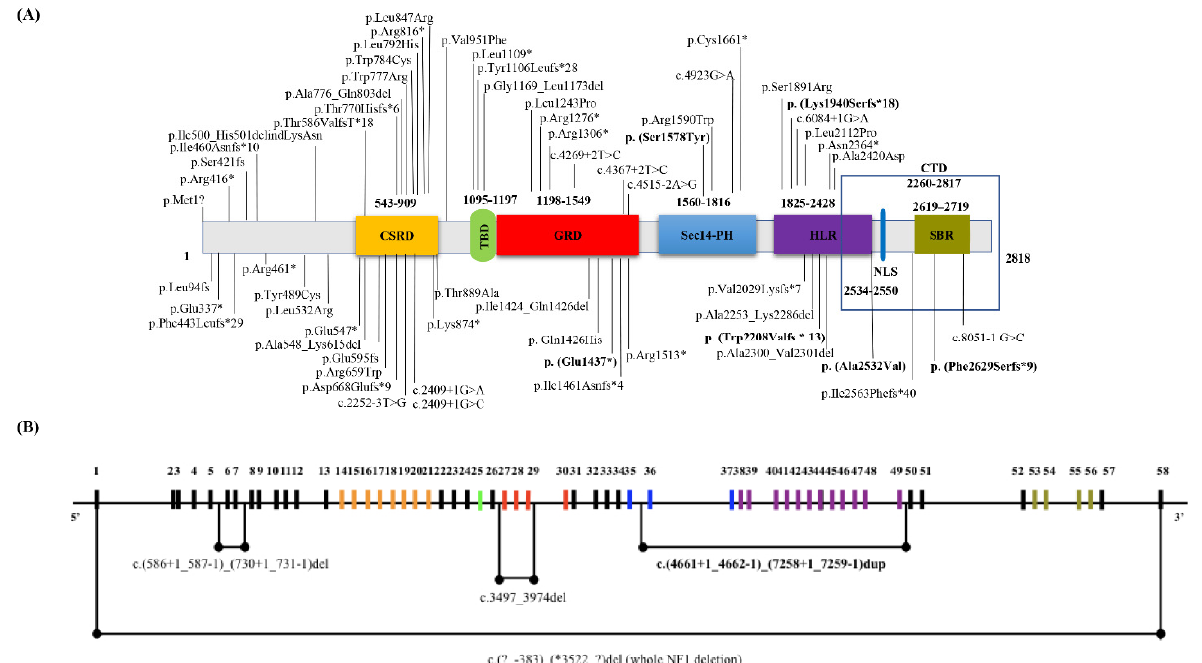
Figure 1. ( A ) Distribution of the identified mutations in the NF1 gene. Details of the 66 NF1 genetic mutations identified in our NF1 Italian cohort. The position of genetic variations detected in the NF1 from each NF1 patient is shown and their distribution in the NF1 domains is reported. Vertical lines show variant position. NF1 novel variants are shown in bold. Neurofibromin domains: CSRD, cysteine/serine-rich domain (543–909 residues); GRD, GAP related domain (1198–1549 residues); TBD, tubulin-binding domain (1095–1197 residues); HLR, HEAT-like repeat regions (1825–2428 residues); NLS, nuclear localization signal (2534–2550 residues); Sec14-PH, Sec14-homologous domain (1560–1816 residues) and Pleckstrin Homology domain (1716–1816 residues); CTD, C-terminal domain (2260–2817 residues); SBR, Syndecan-Binding Region (2619–2719 residues). ( B ) Map of the NF1 region indicating the large duplications and deletions sequences identified in our NF1 cohort. The black horizontal line represents the entire NF1 gene, while the vertical lines indicate the NF1 exons. Different colors were used for NF1 exons according to the relative functional domains as shown in ( A